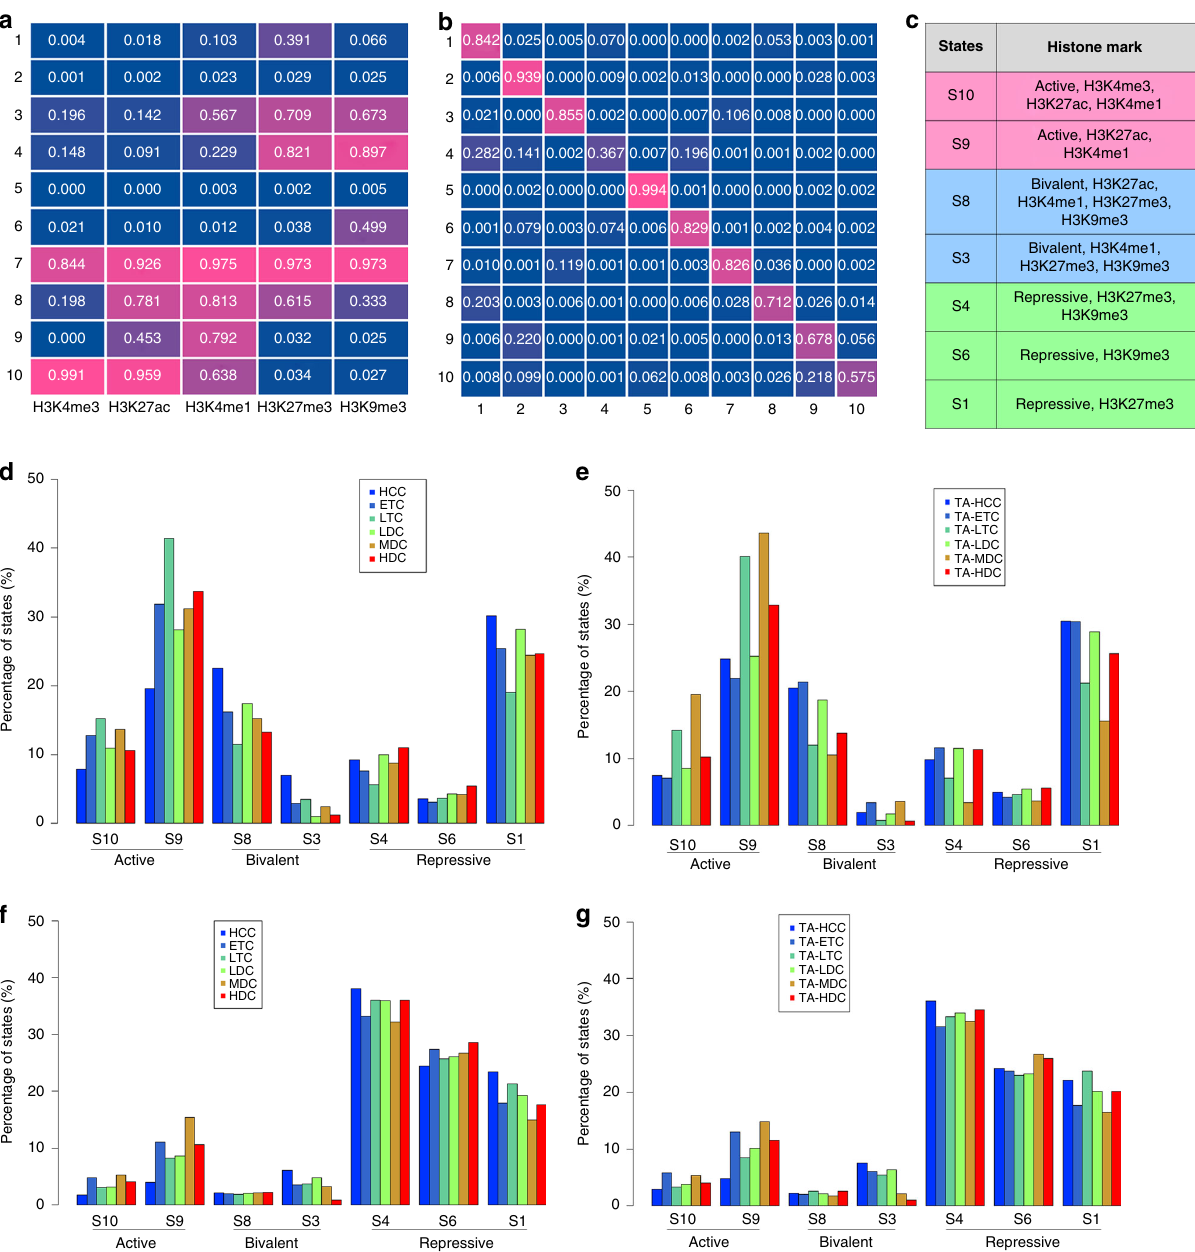
Fig. 4 Epigenetic modi fi cations on E2-induced TDRCs and TRACs. a Emission probabilities of ten epigenetic states trained by an HMM model on fi ve histones. The enrichment of the corresponding mark indicated by high values and dark red color. b Transition probabilities of ten epigenetic states trained by an HMM model on fi ve histones. The enrichment of the corresponding mark indicated by high values and dark red color. c The summary of the corresponding histone marks to each of biologically meaning epigenetic states. d The percentage of epigenetic states on dynamic E2-induced compartment A. e The percentage of epigenetic states on altered TamR compartment A. f The percentage of epigenetic states on dynamic E2-induced compartment B. g The percentage of epigenetic states on altered TamR compartment B. TDRC temporally dynamic re-compartmentalization, TRAC tamoxifen-resistant altered course of E2 treatment in MCF7 cells as well as in asynchronous these states back into each of six types of E2-induced dynamic TamR cells, each with biological replicates (Supplementary compartments and TamR altered compartments. Overall, Table 3). We fi rst trained a total of 30 histone modi fi cation we observed that more active states were distributed in com- data by ChromHMM at various parameters 45 , and obtained partment A and more repressive states in compartment B, while ten HMM states (Fig. 4a, b). Through interpreting both HMM three types of dynamic changed compartments, i.e., LDC, emission and transition probabilities, we inferred seven biologi- MDC and HDC, have a higher percentage of active states cally meaningful epigenetic states, including two active states than HCC does (Fig. 4d − g). Surprisingly, S1 showed a high (S9 and S10), two bivalent states (S3 and S8) and three repressive percentage of distribution in compartment A despite that it is a states (S1, S4 and S6) (Fig. 4c). We were also able to map repressive state.